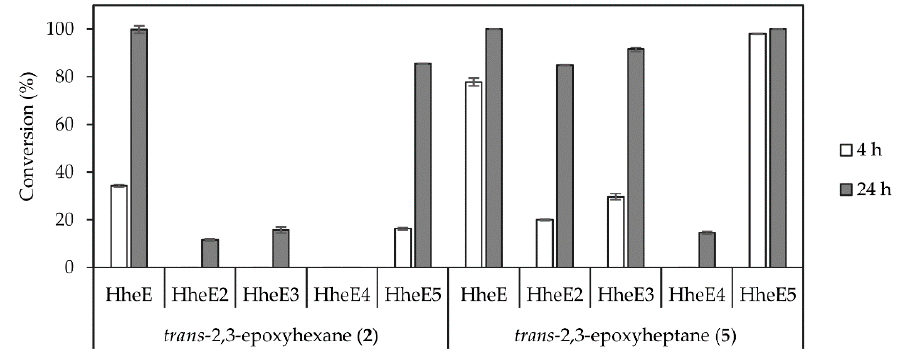
Figure 2. Conversion of racemic epoxides 2 ( left ) and 5 ( right ) using the regioselective HHDHs from subtype E as whole cell catalysts (60 g/L, wet cell weight). Each reaction was carried out in duplicate using 10 mM substrate, 50 mM NaN 3 in 1 mL 50 mM KPi buffer pH 7.5 at 25 °C.